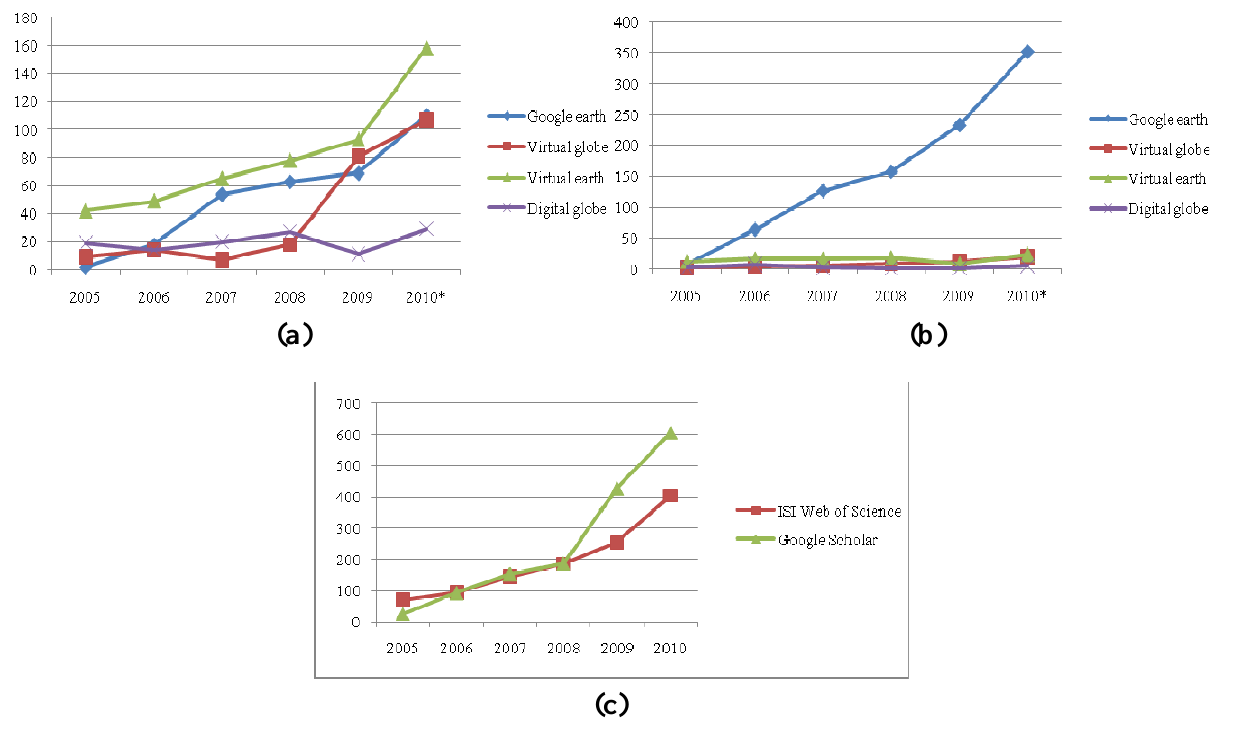
Figure 3. Number of publications during 2005–2010. ( a ) Total publications as per ISI Web of Knowledge; ( b ) Total publications as per Google Scholar; ( c ) Cumulative number of publications by different